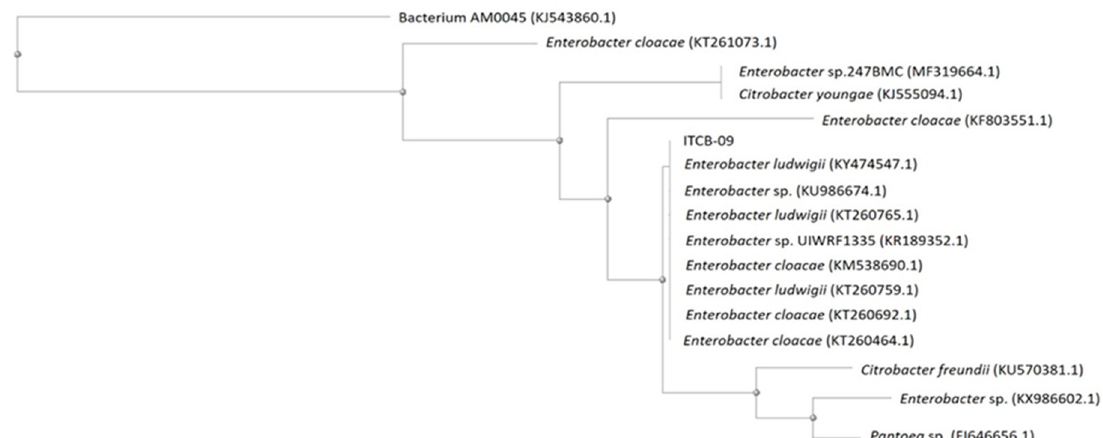
Figure 2. Neighbor-joining dendrogram constructed from the 16S rDNA region of isolate ITCB-09 and other bacterial taxa with high nucleotide similarity from the GenBank database. The percentage of replicate trees in which the associated taxa clustered together in the bootstrap test (1000 replicates). The tree is drawn to scale, with branch lengths in the same units as those of the evolutionary distances used to infer the phylogenetic tree. The evolutionary distances were computed using the p-distance method and are in the units of the number of base differences per site.